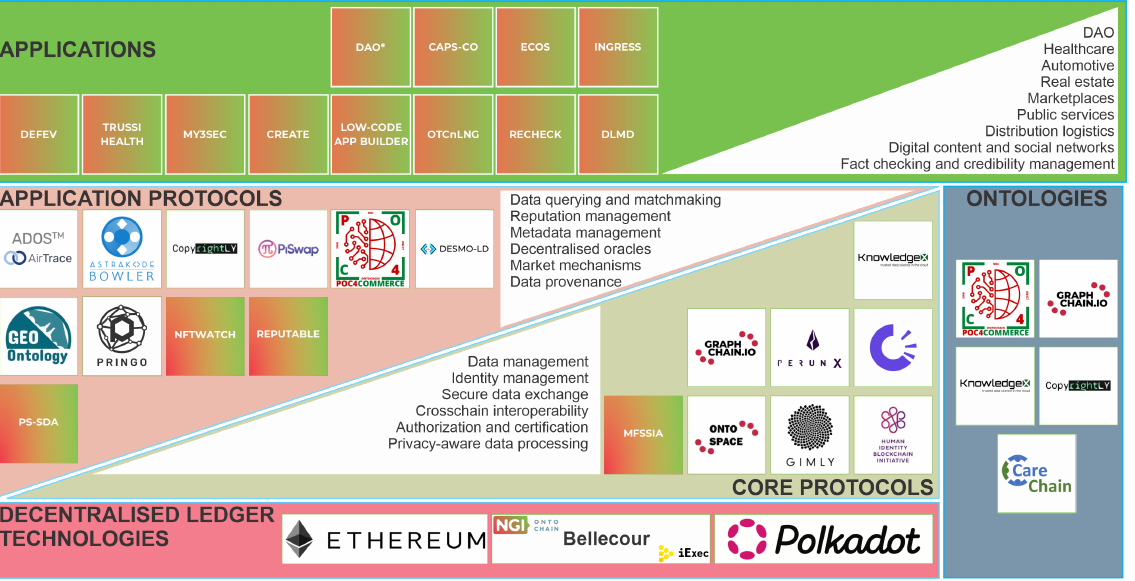
Figure 2. ONTOCHAIN high-level